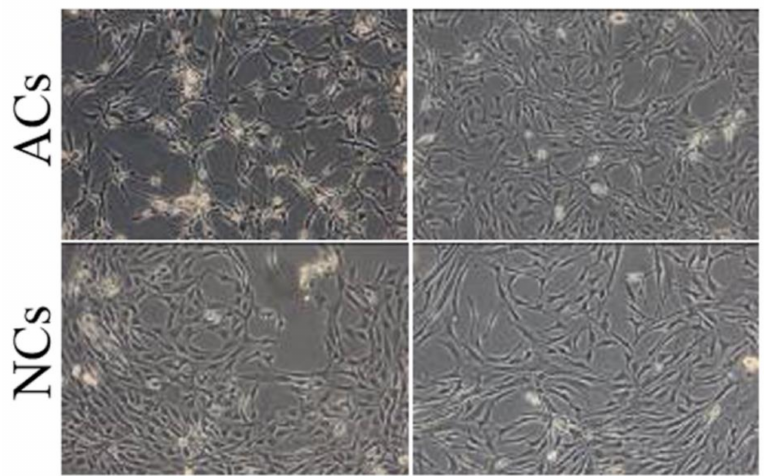
Figure 2. Optical microscope images of two different cell lines of articular (ACs) and nasal septal (NCs) chondrocytes cultured in monolayer condition until sub-confluence for eight and 14 days, respectively (25 × magnification). Cells appeared as spindle-shaped without morphological